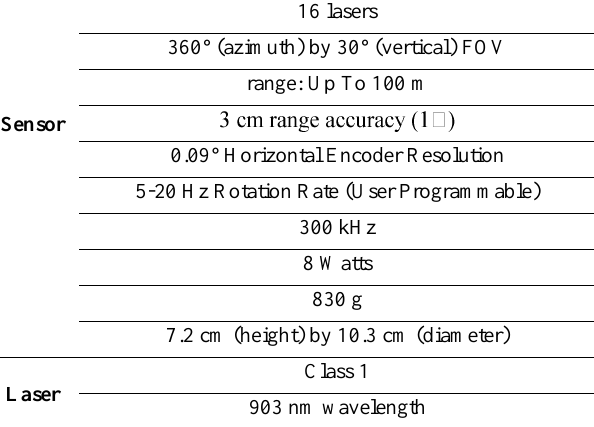
Table 1. Manufacturer Specifications of the Velodyne